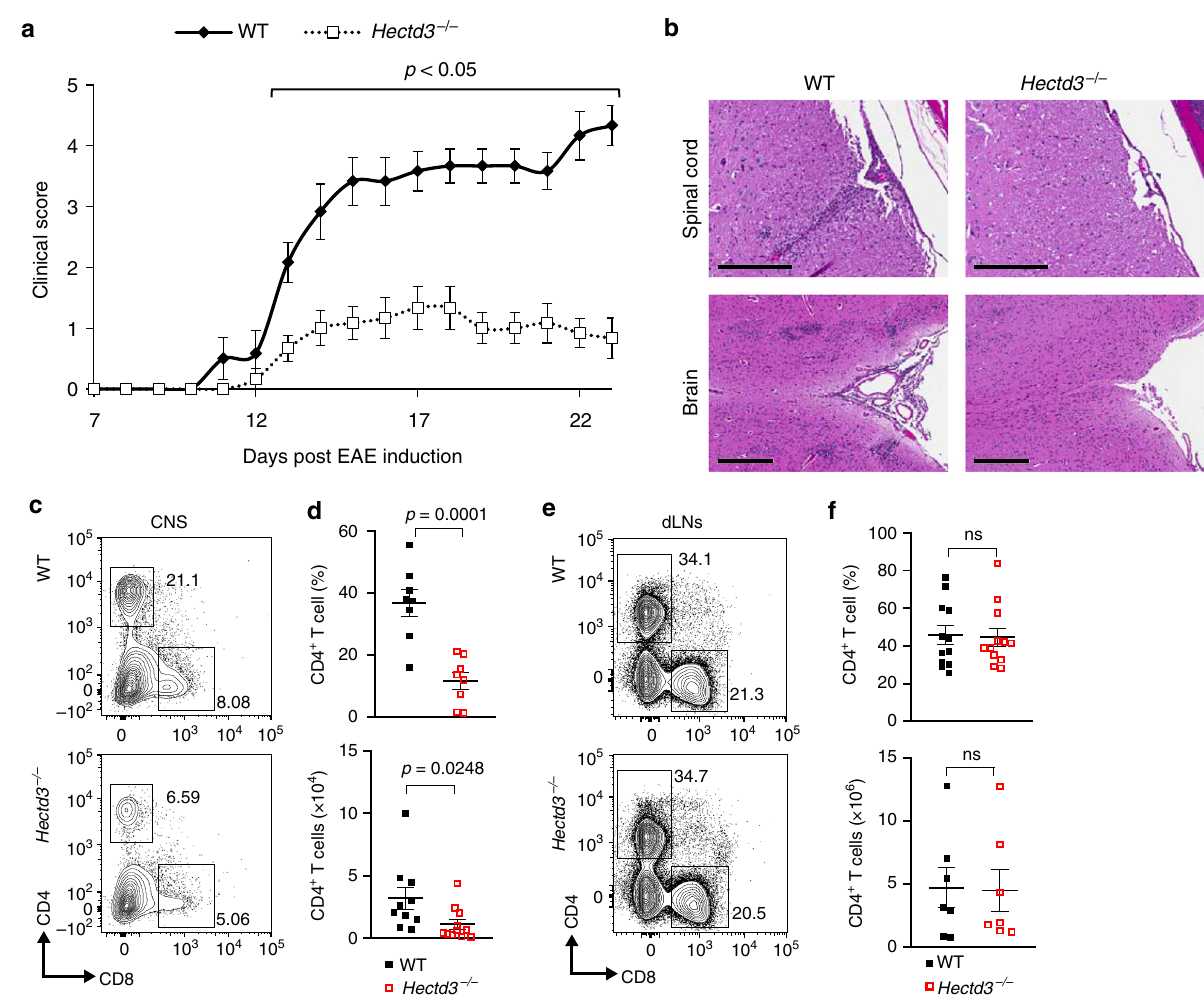
Fig. 2 Hectd3-de fi cient mice have attenuated EAE severity with reduced CD4 + T cell in fi ltration in the CNS. a EAE disease scores (mean±SEM) of Hectd3 − / − (open) and wild-type (WT) ( fi lled) mice following EAE induction, n = 6 per group, from three independent experiments. EAE induction was conducted as described in Material and methods. Description of clinical scores for EAE is presented in Material and methods. b Representative spinal cord and brain hematoxylin and eosin staining of Hectd3 − / − and WT mice 16 days following EAE induction; black bars represents 200 μ m for spinal cord sections and 300 μ m for brain sections; n = 4 per group, from three independent experiments. c Flow cytometry analysis of CD4 + and CD8 + T cells in the CNS of Hectd3 − / − and WT mice 13 days following EAE induction, n = 8 per group from three independent experiments. d Frequencies and absolute numbers (mean ± SEM) of the CNS CD4 + T cells in Hectd3 - − / − and WT mice, 13 days following EAE induction. e Flow cytometry analysis of CD4 + and CD8 + T cells in draining lymph nodes (dLNs) of Hectd3 − / − and WT mice 13 days following EAE induction; n = 10 per group from three independent experiments. f Frequencies